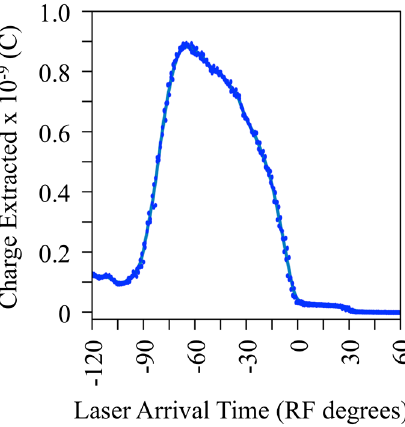
FIG. 2. Schottky scan from CsBr taken at 80 MV = m field showing a maximum charge extracted of 0.9 nC at − 65 ° phase.